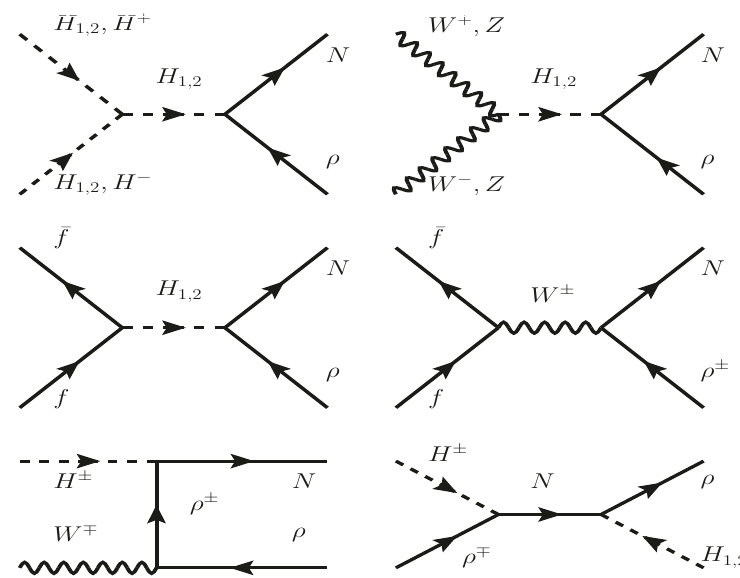
Figure 19 . Production channels for